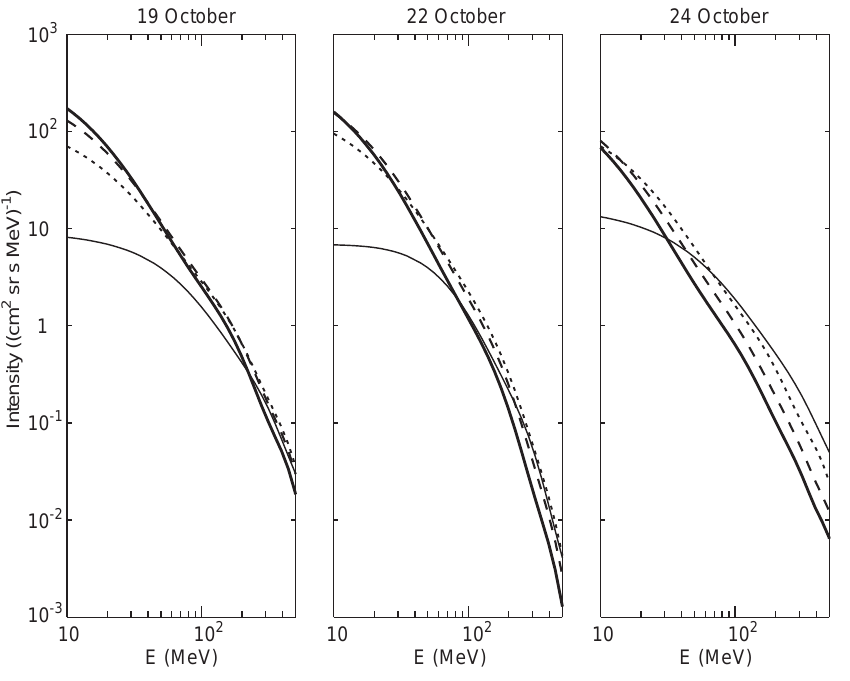
Fig. 8. Deconvolved proton spectra at the Earth orbit for the CME-associated events of 19, 22 and 24 October at the moments t (cid:136) 300 min ( thin solid line ), t (cid:136) 600 min ( dotted line ), t (cid:136) 900 min ( dashed line ) and t (cid:136) 1200 min ( thick solid